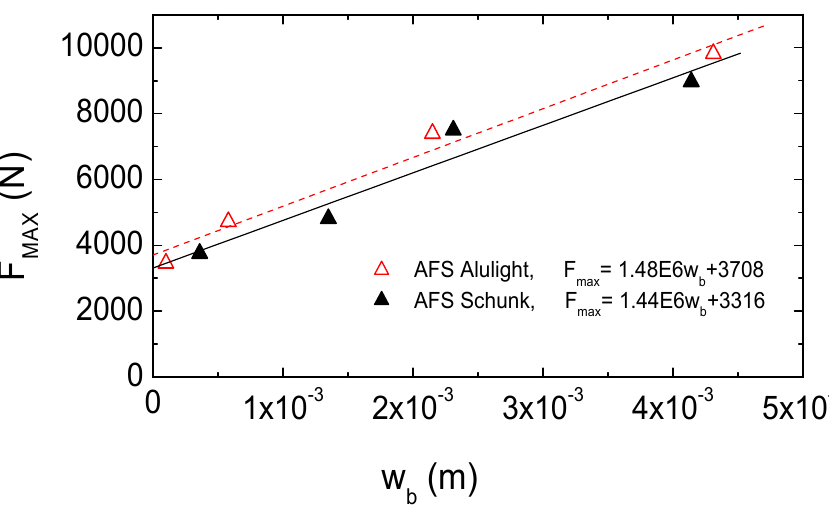
panels. The core compression displacement α is obtained by the subtraction between the impactor and the vertical displacement w displacement w i Figure 14. Measurements of the displacements w